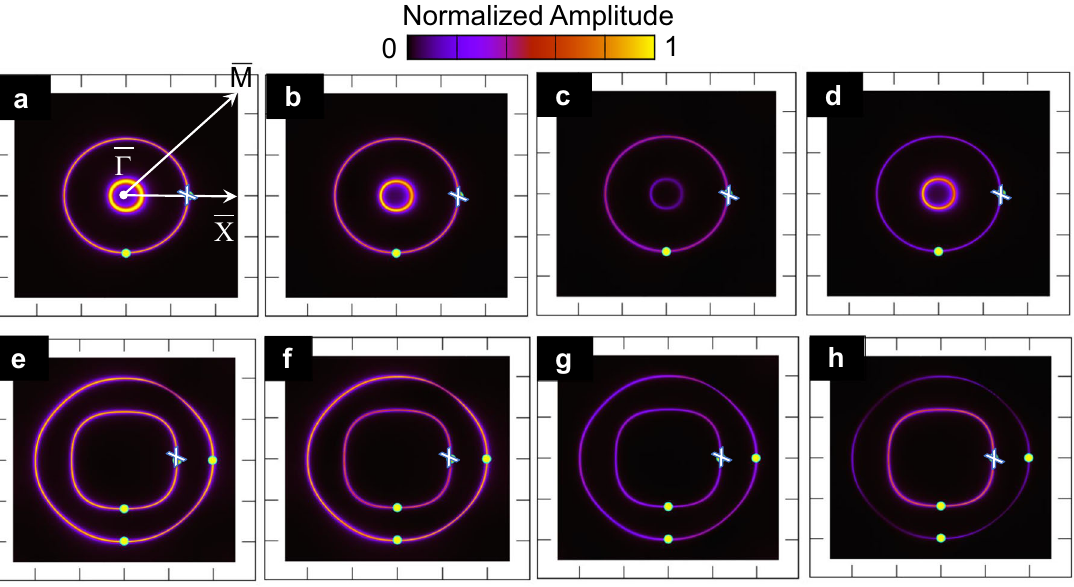
Fig. 7 Two-dimensional momentum space distribution of magnons in the Co/Fe/Co system. The energy cuts are chosen so that the wavevector of 0.7 Å − 1 along the high symmetry (cid:1) Γ – (cid:1) X is highlighted ( (cid:1) Γ and (cid:1) X represent the high symmetry points of the surface Brillouin zone). This corresponds to the outer ring in panels ( a – d ) and the inner ring in panels ( e – h ). The other rings are due to the magnons with other wavevectors, which share the same energy. Panels a – d are the results for the magnon energy of 76 meV (magnons with n = 0) and e – h are the results for the magnon energy of 123 meV (magnons with n = 1). The total Bloch spectral function is shown in panels ( a , e ). The Bloch spectral function projected into the interface ( b , f ), middle ( c , g ), and surface layer ( d , h ) is also